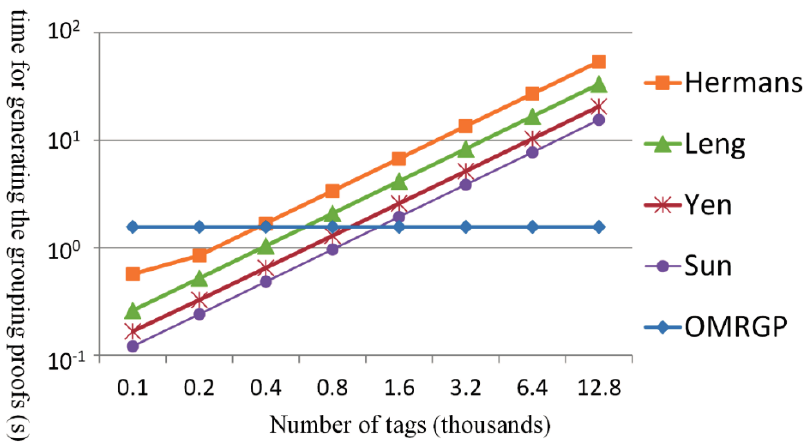
Figure 12. Comparing the time for generating grouping